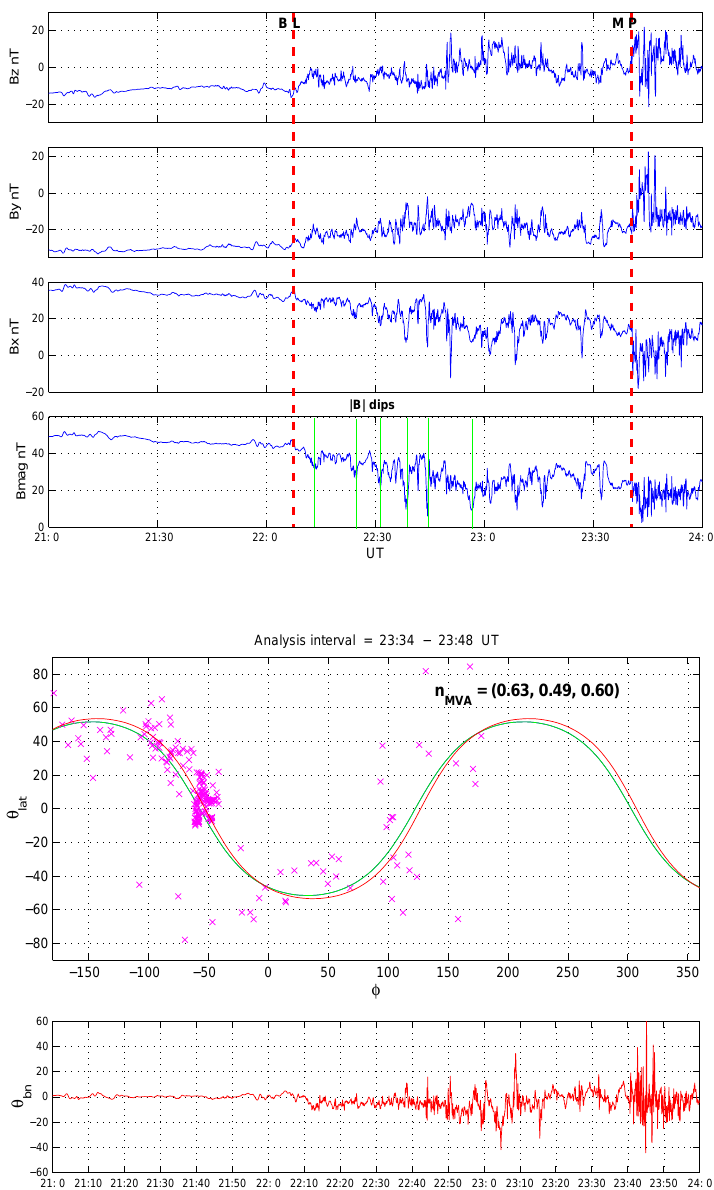
Fig. 11. (a) A scatter plot of the GSE magnetic field angles observed by Cluster 2 from 23:34–23:48UT (pink crosses), and a best fit curve corre- sponding to a planar fit to the data (green curve) (top panel). Overplot- ted in red is the curve corresponding to a plane derived from a minimum variance analysis (n MVA )from the same interval. (b) The magnetic angle out of the minimum variance plane ( θ bn ) observed by Cluster 2 for the interval 21:00–24:00UT on 9 December 2000 (bottom